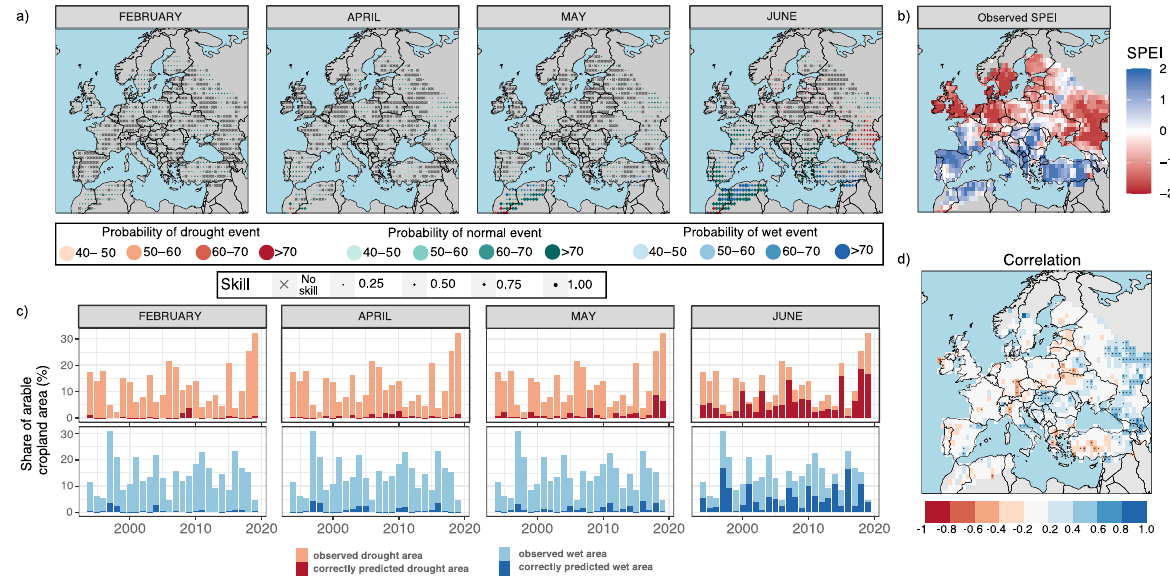
Fig. 3 Prediction of drought between wheat heading and maturity. a Prediction of dry/normal/wet events between wheat heading and maturity in 2018 based on seasonal climate forecasts initialized in February, April, May, and June. The size of the circles is proportional to the forecast skill of the climate indicator. b The observed SPEI between heading and maturity in 2018. c Cumulative proportion of European arable land affected by drought and wet events during the heading and maturity period. Dark red (blue) colors indicate the share of drought (wetness) affected area that is correctly predicted by the seasonal climate forecast initialized in February, April, May, and June. Only the arable cropland where the FRPSS is positive is considered for the calculation of the predicted drought and wetness affected area. d Correlation between the SPEI calculated in two distinct periods: stem elongation-heading,